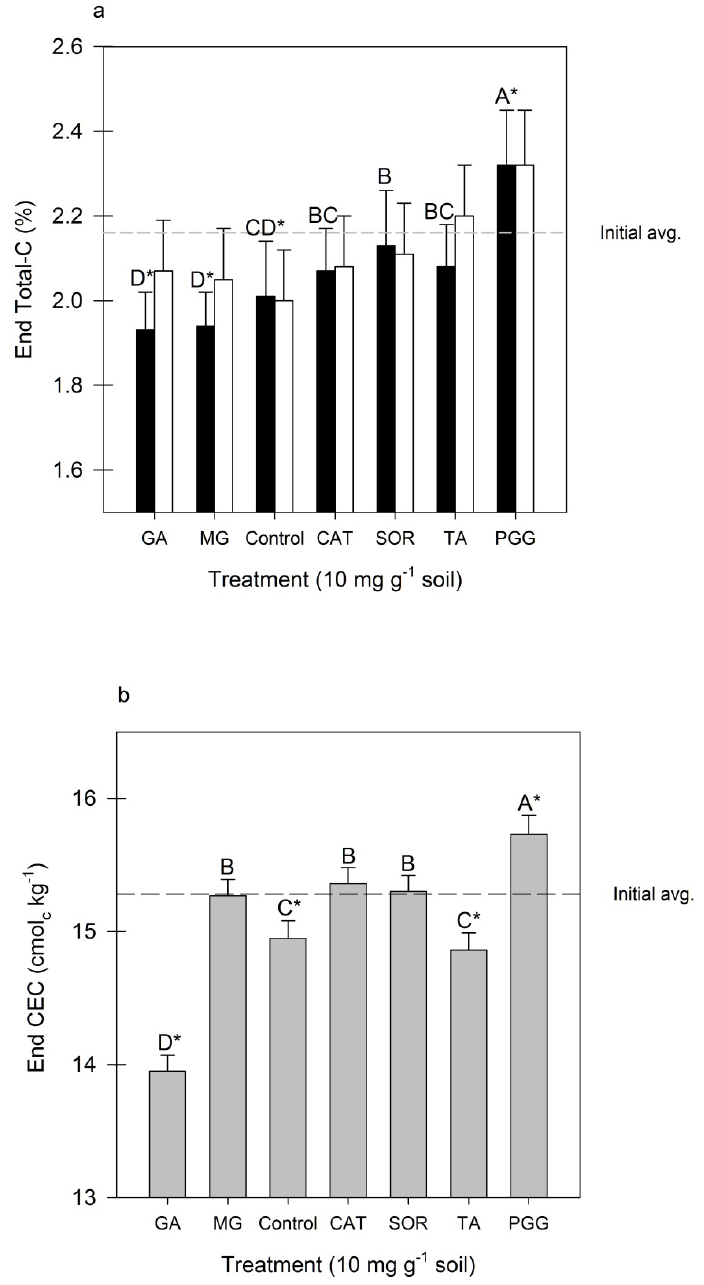
Figure 5. Mean and standard error of treatment effects on: ( a ) Total-C in soil after the hot water incubation (black bar) compared to predicted values (open bar) calculated with equation 3; and ( b ) final soil cation exchange capacity. Differences among measurement means are denoted by letters (n = 8, Tukey’s HSD). Significant differences from initial soil total-C are denoted by asterisk (paired t-test, P ≤